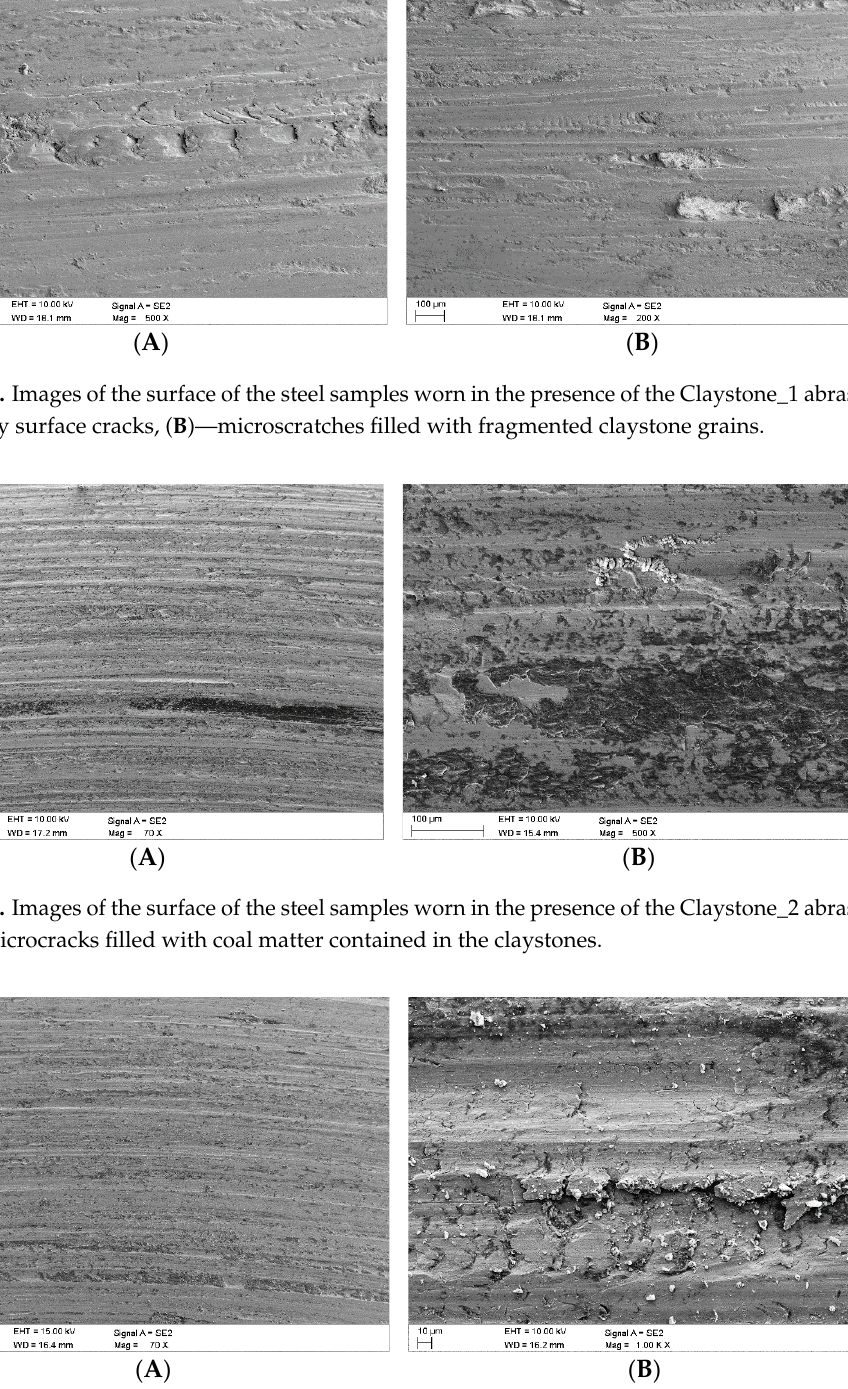
Figure 14. Images of the surface of the steel samples worn in the presence of the Claystone_3 abrasive; ( A )—microscratches filled with crushed claystone grains, ( B )—scaly surface cracks against the background of the